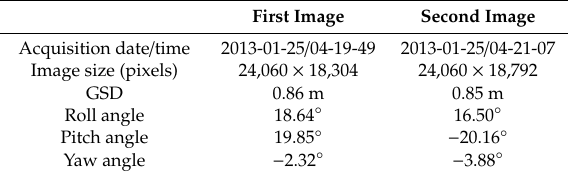
Figure 4. Study area: (a) and (b) KOMPSAT-3 stereo pair for Yangsan, (c) and (d) map of the Korean peninsula with the Yangsan city region in South Korea. Table 1. Specifications of the satellite images used.